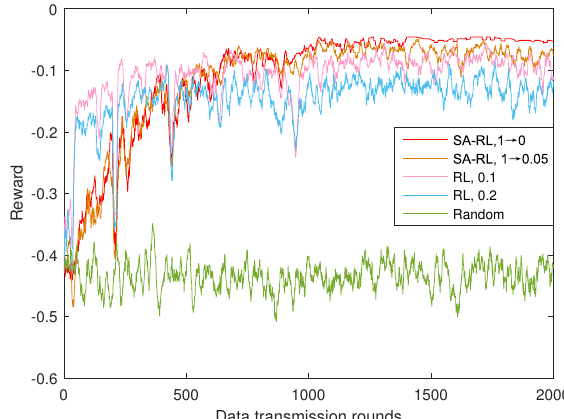
Figure 7. Comparison of rewards of RL with/without SA strategy.